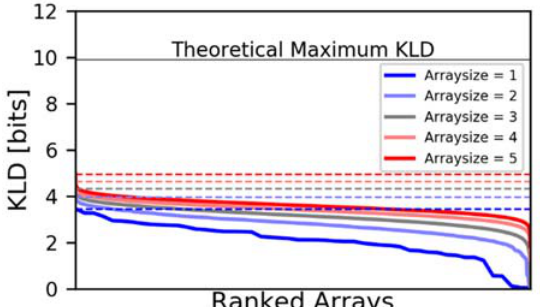
Figure 3. Validation of the genetic algorithm (dashed lines) against brute force screening (solid lines) for 1 ‐ to 5 ‐ element arrays. The dashed lines are the best array of each size predicted by the genetic algorithm, and the solid lines are all arrays from the brute force screening. There are more arrays as array size increases; the results are simply stretched so that the best/median/worst arrays are vertically aligned.